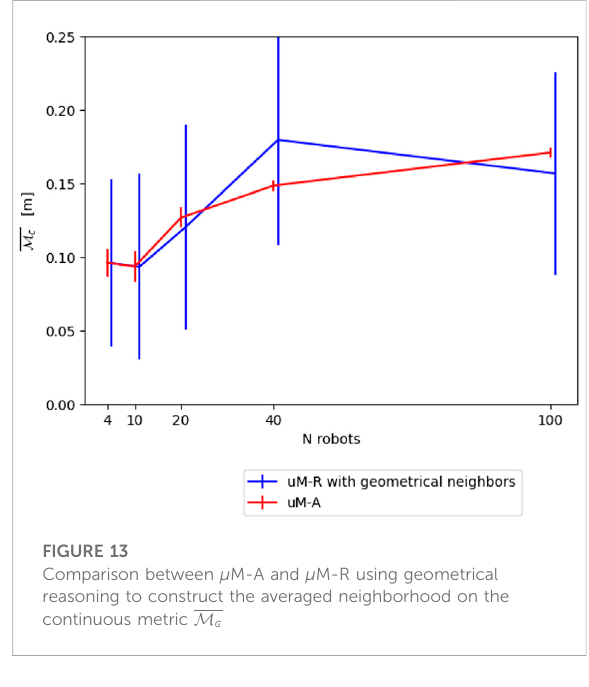
FIGURE 13 Comparison between μ M-A and μ M-R using geometrical reasoning to construct the averaged neighborhood on the continuous metric M c